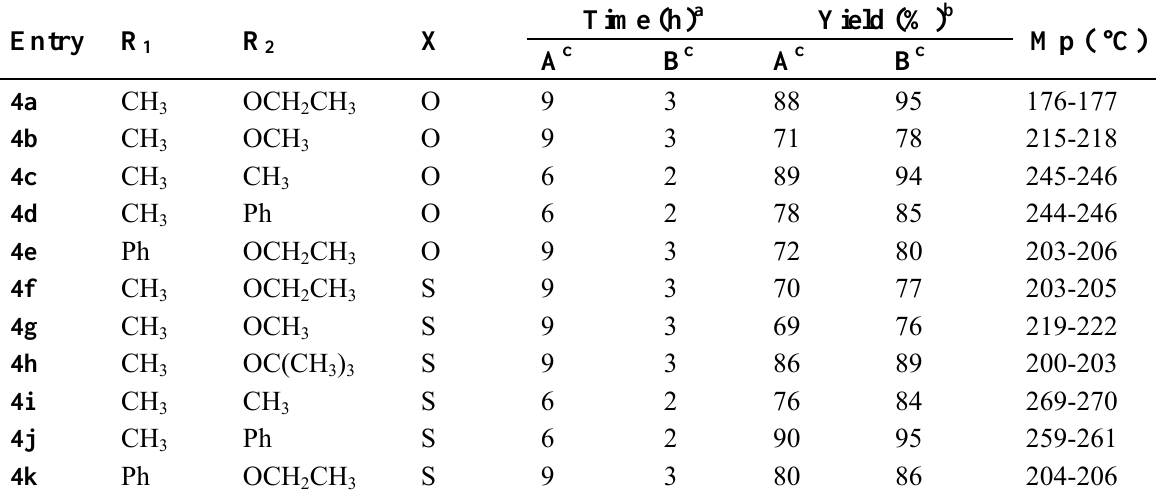
) -catalyzed one-pot three-component synthesis of 4 3